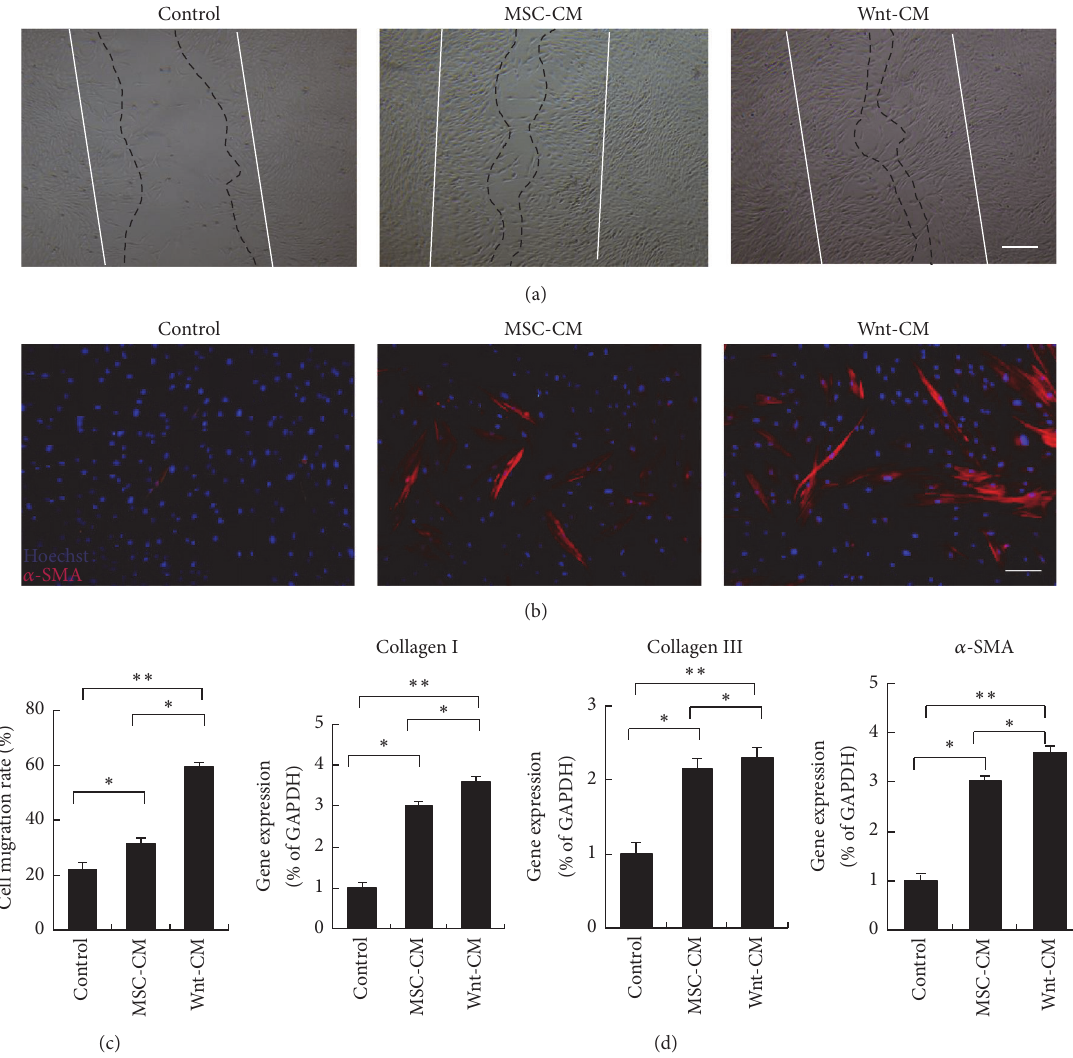
Figure 4: Wnt-CM stimulates migration and promotes expression of 𝛼 -SMA and ECM components in fibroblasts. (a) Wnt-CM enhanced migrationofprimaryhumanfibroblastsinawoundscratchassay(after24h)ascomparedtoMSC-CMandDMEM.(b)Immunocytochemical staining for 𝛼 -SMA shows upregulation of 𝛼 -SMA induced by Wnt-CM. (c) Quantification of optical density of the immunocytochemical staining for 𝛼 -SMA. (d) Expression levels of 𝛼 -SMA, collagen III, and collagen I mRNA after treatment with DMEM, MSC-CM, or Wnt-CM were analyzed by RT-PCR and normalized to that of GAPDH. The data represent mean ± SEM, 𝑛 = 3 ; ∗ 𝑃 < 0.05 and ∗∗ 𝑃 < 0.01 . Solid lines indicate the initial wound area; dotted lines demarcate the migrating front of the cells. The scale bar is 100 𝜇 m in panel (a) and 50 𝜇 m in panel